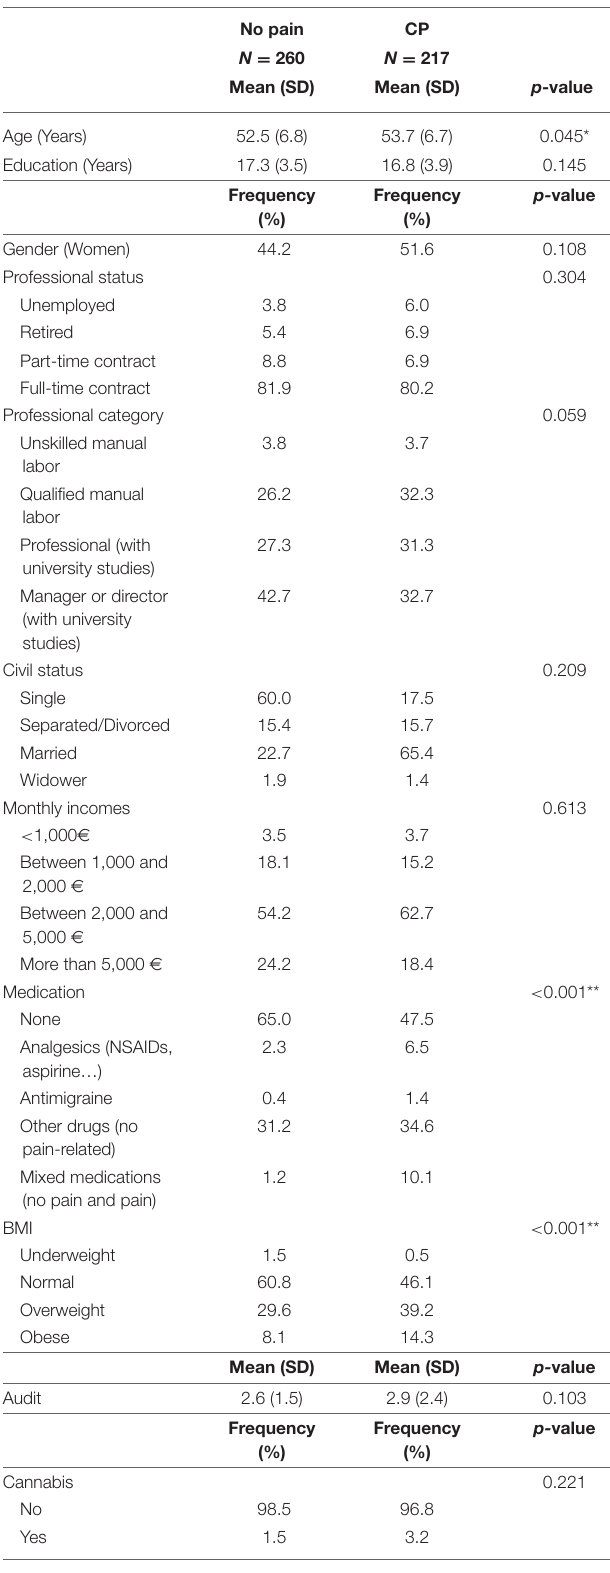
TABLE 1 | Sociodemographic data of